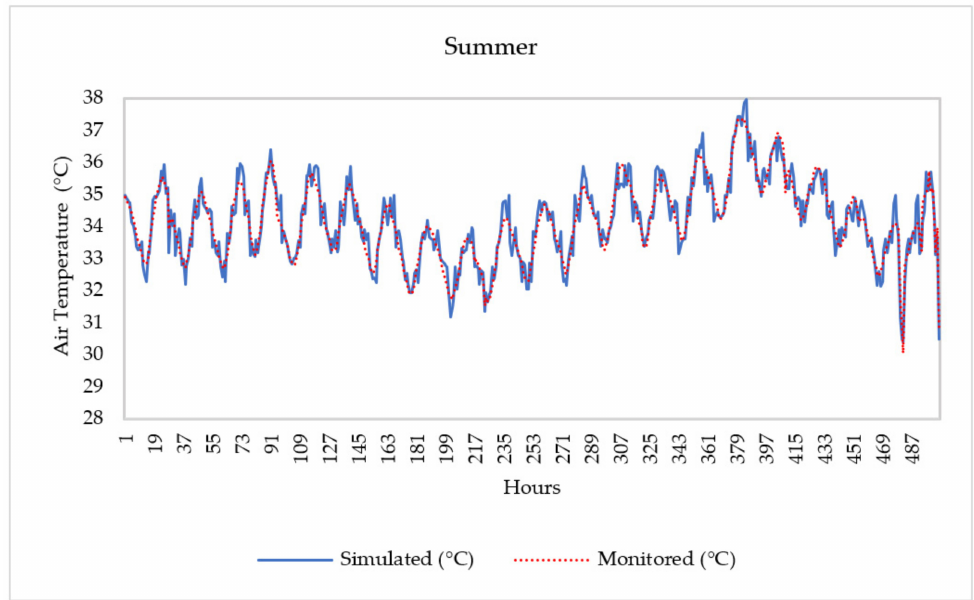
Figure 3. Validation of the calibration based on measured and simulated air temperature in the living room of the selected base case building during summer 2019.